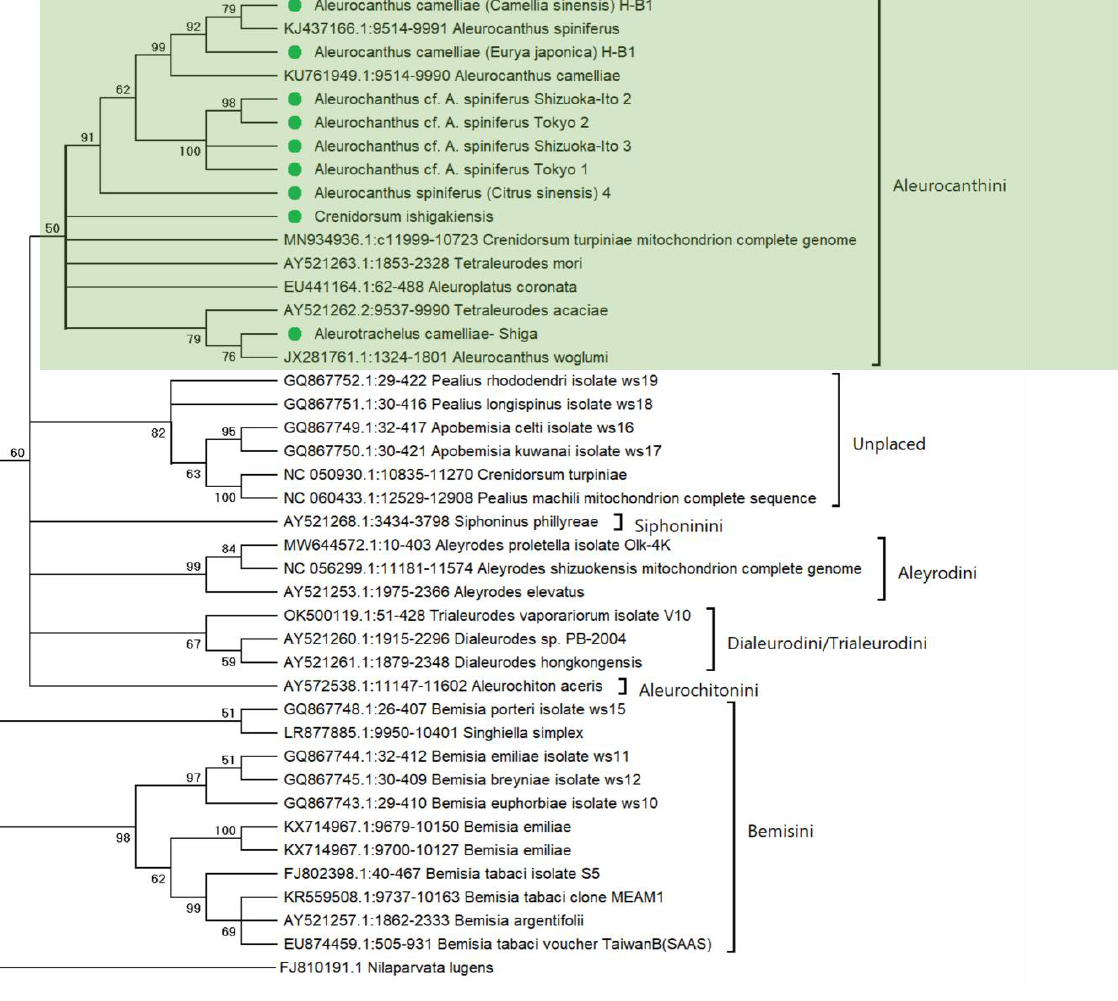
Figure 6. Cladogram of 16S mitoribosome constructed using Jukes – Cantor model [85] with partial deletion option. Forty-two sequences retrieved from the database were included in the analysis. The sequence of Nilaparvata lugens (No. FJ810191) was placed as an out-group. The green circles are the samples examined. Alignment length 416 bp. Note: identical sequences of Crenidorsum turpiniae (NC_050930.1) with Pealius machili (NC_060433.1) suggested they were contaminated or misidenti-